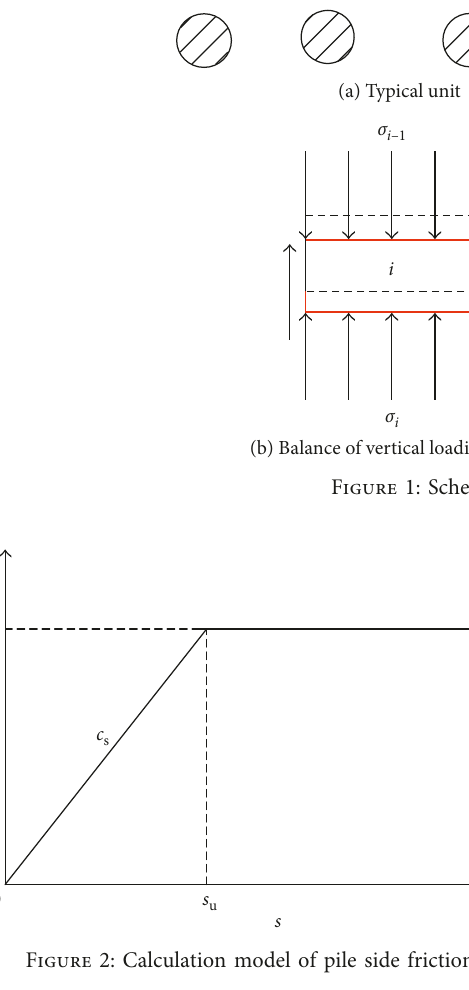
Figure 3: Pile top resistance-displacement